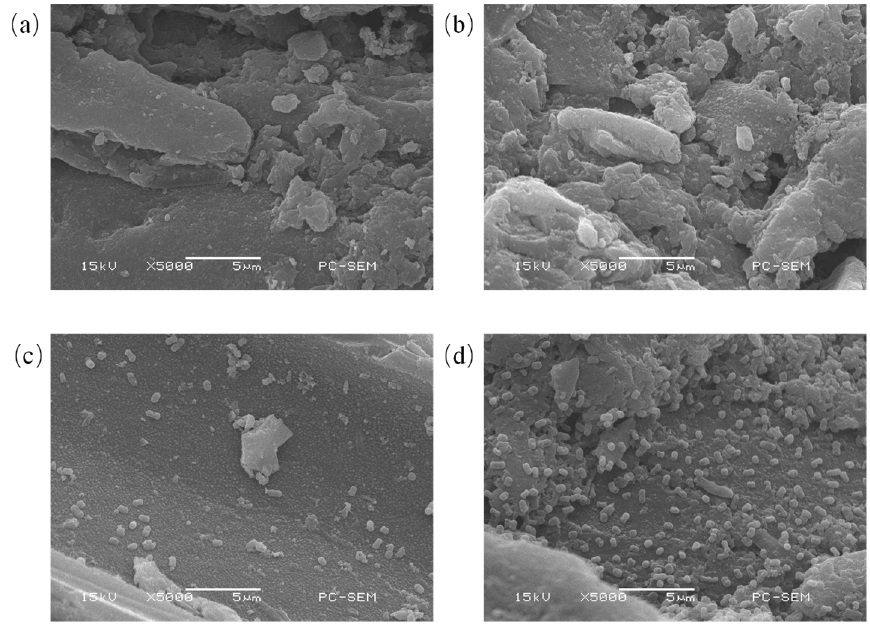
Figure 1. SEM images of granular activated carbon and immobilized cells. ( a ) GAC, ( b ) NaOH-GAC, ( c ) GAC-immobilized cells, ( d ) NaOH-GAC-immobilized cells. Table 3. Immobilized biomass.